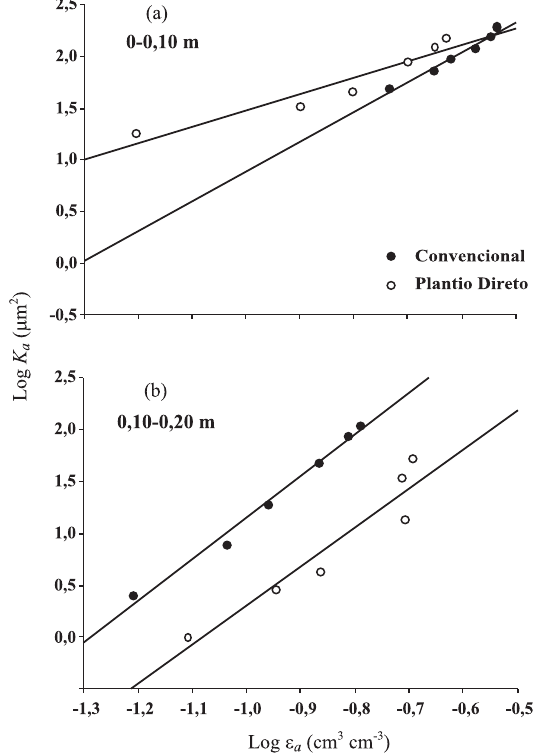
Figura 3. Relação logarítmica entre K Latossolo Vermelho distrófico para dois siste- mas de manejo do solo e duas profundidades. Cada ponto representa a média das 20 amostras de cada tratamento nos seis potenciais mátricos (-2, -6, -10, -30, -70 e -100